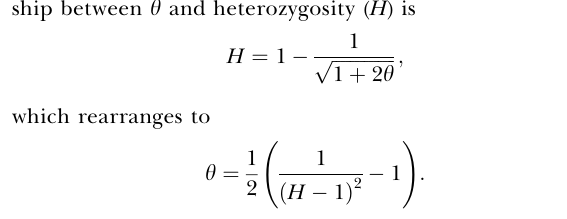
Figure 1. Populations Included in This